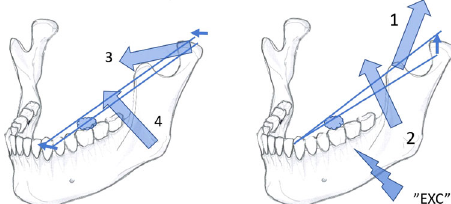
Fig. 6 The intermitting bout of vertical muscle force during the horizontal closure phase of the human unilateral chewing cycle. The left panel shows the medial movement of mandible (small, horizontal arrows), driven by the horizontal muscle complex (large arrows, 3 and 4). The food bolus becomes condensed in the fi rst molar area and possibly distracts the ipsilateral synovial space. The right panel illustrates excitatory inputs from the BAT-area ( “ EXC ” ). The temporal-masseter-complex (large arrows, 1 and 2) is instanta- neously re-activated to crush the bolus vertically (small arrow) with the class 2 lever system. The diminished bolus allows, once again, an increase of the inhibitory ANT-contacts to reinstate the activity of the antagonist, horizontal complex of muscles and the mandible continues to move medially. closure silenced its antagonist, the horizontally oriented complex of muscles takes over. The activated inferior belly of the lateral pterygoid muscle and the medial pterygoid muscle provide muscle force for the continuation of the medially directed movement of mandible. 16 – 18 The food bolus now becomes laterally compacted against the almost perpendicular, opposite slopes of the central fossae of the bilophodont BAT (Fig. 5b). Thus, the medially directed, forceful grinding (Fig. 6, left panel) compacts the food bolus to increase the excitatory BAT-inputs. In addition, the ipsilateral glenoid area becomes distracted to (Fig. 4, middle) to cause spindle-mediated excitatory inputs of the vertical complex of muscles. As result, the temporal-masseter- complex is cyclically activated, over-and-over-again for supple- mentary coups of class 2 levered vertical force amidst the horizontal grinding process (Fig. 6, right panel). The evolutionally unique human mastication The human mastication enables ef fi cient muscle-driven horizontal grinding with intermitting bouts of vertical force subjected to the entire BAT-area, whereas apes and monkeys seem to protrude their jaw slightly and use their ANT only for the horizontal grinding of food. Their relatively large ANT commonly exhibit edge-to-edge contacts and signi fi cant age-related wear, whereas the original inclines of the cusps and fossae of the BAT, except for the C/P3 honing complex, are generally well discernible after decades of arduous chewing of fi brous food.